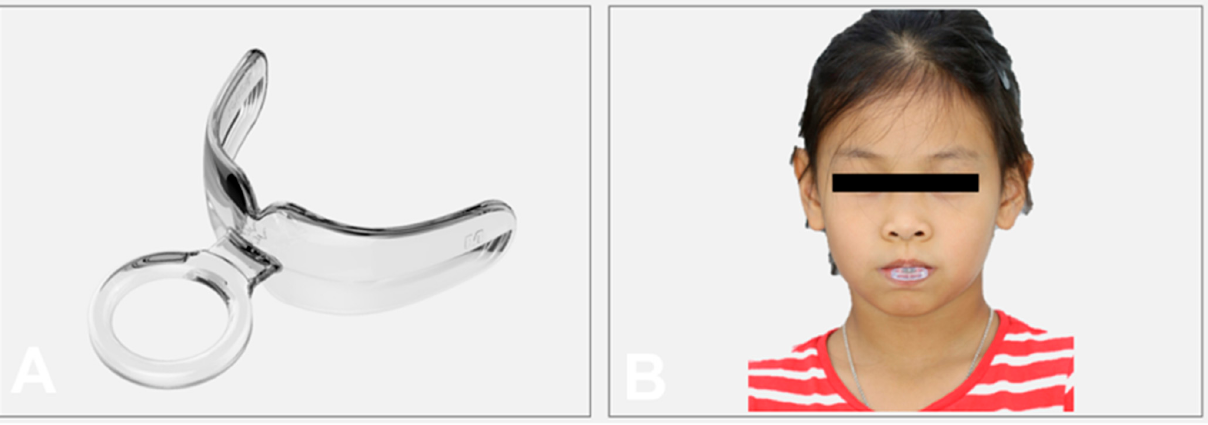
Figure 2. NOA™ ‐ T: ( A ) the vertical view; ( B ) the extraoral view.